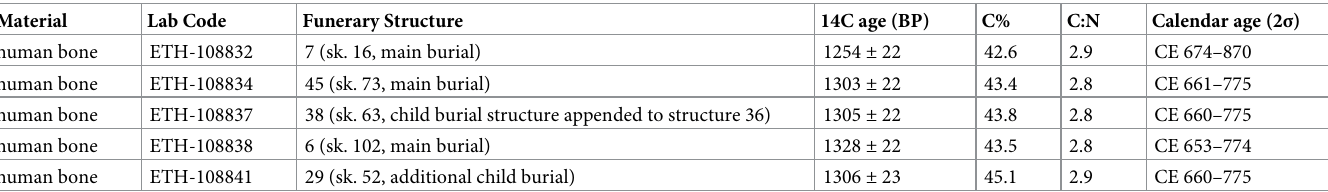
Table 1. 14C dates of bone